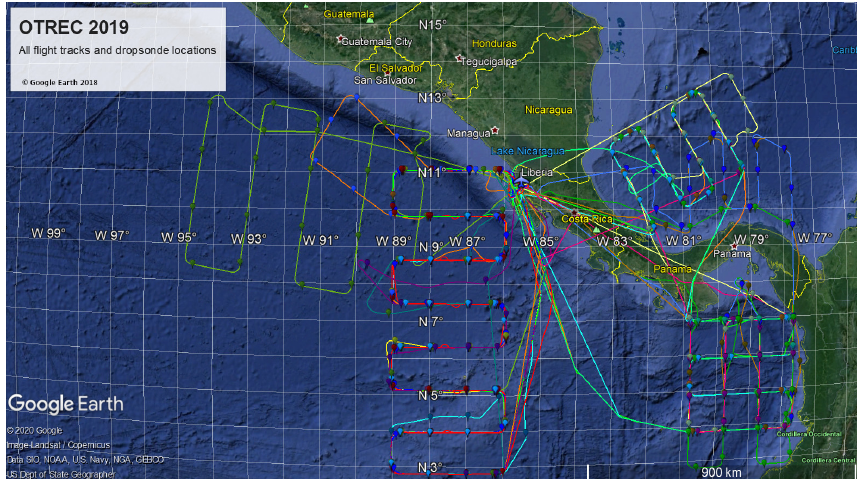
Figure 2. All flights tracks and all dropsonde locations during